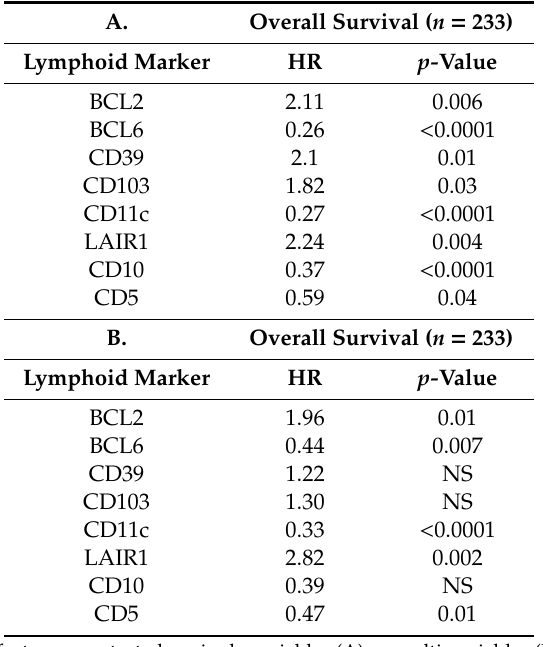
Table 2. Cox univariate and multivariate analyses of the e ff ect of lymphoid markers on overall survival in patients with di ff use large B-cell lymphoma (gene expression data from the R-CHOP Lenz cohort, n =